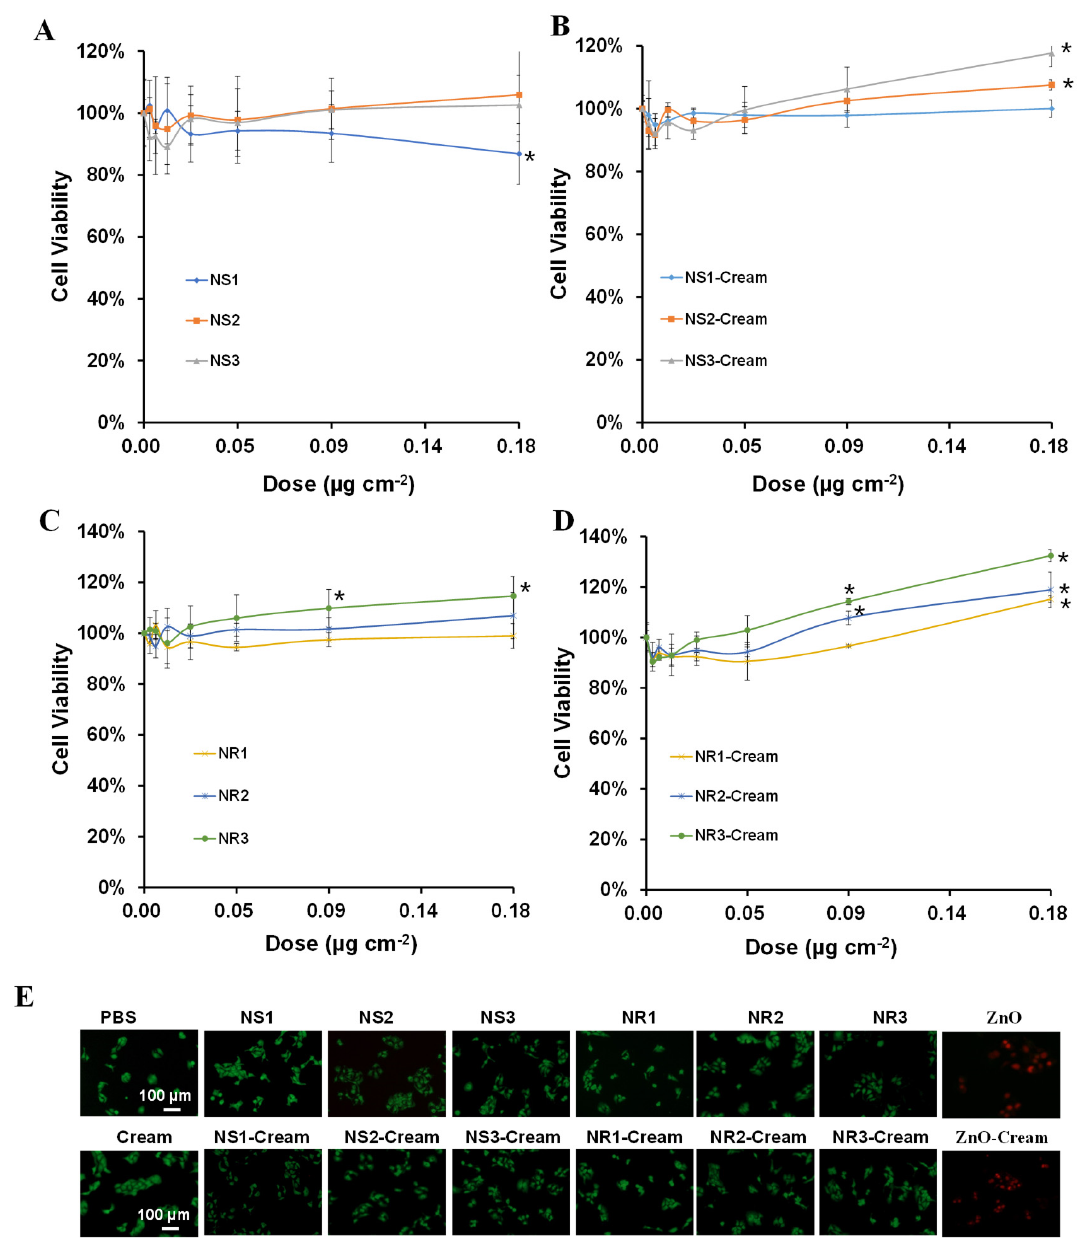
Figure 4. Cell viability assessment of Au NMs and Au NM − Cream in HaCaT cells. CCK-8 −